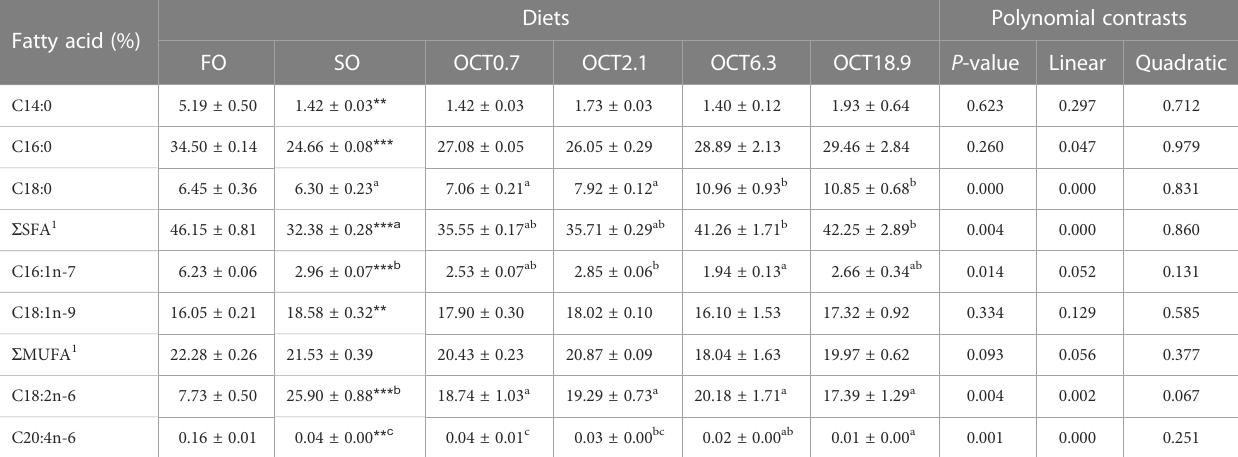
TABLE 2 Fatty acid pro fi les in liver of large yellow croaker in different groups (% total fatty acids).